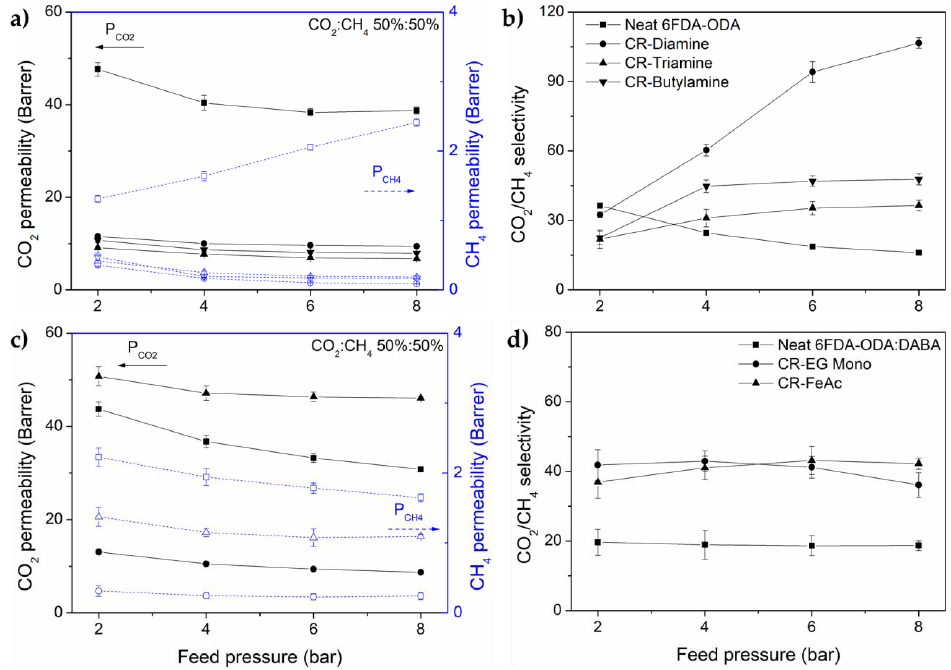
Figure 7. Gas permeability and CO 2 /CH 4 selectivity of ( a , b ) 6FDA-ODA and ( c , d ) 6FDA-ODA:DABA and their respective crosslinked membranes, tested with an equimolar CO 2 /CH 4 feed mixture at 2–8 bar. All measurement was conducted at 25 °C.